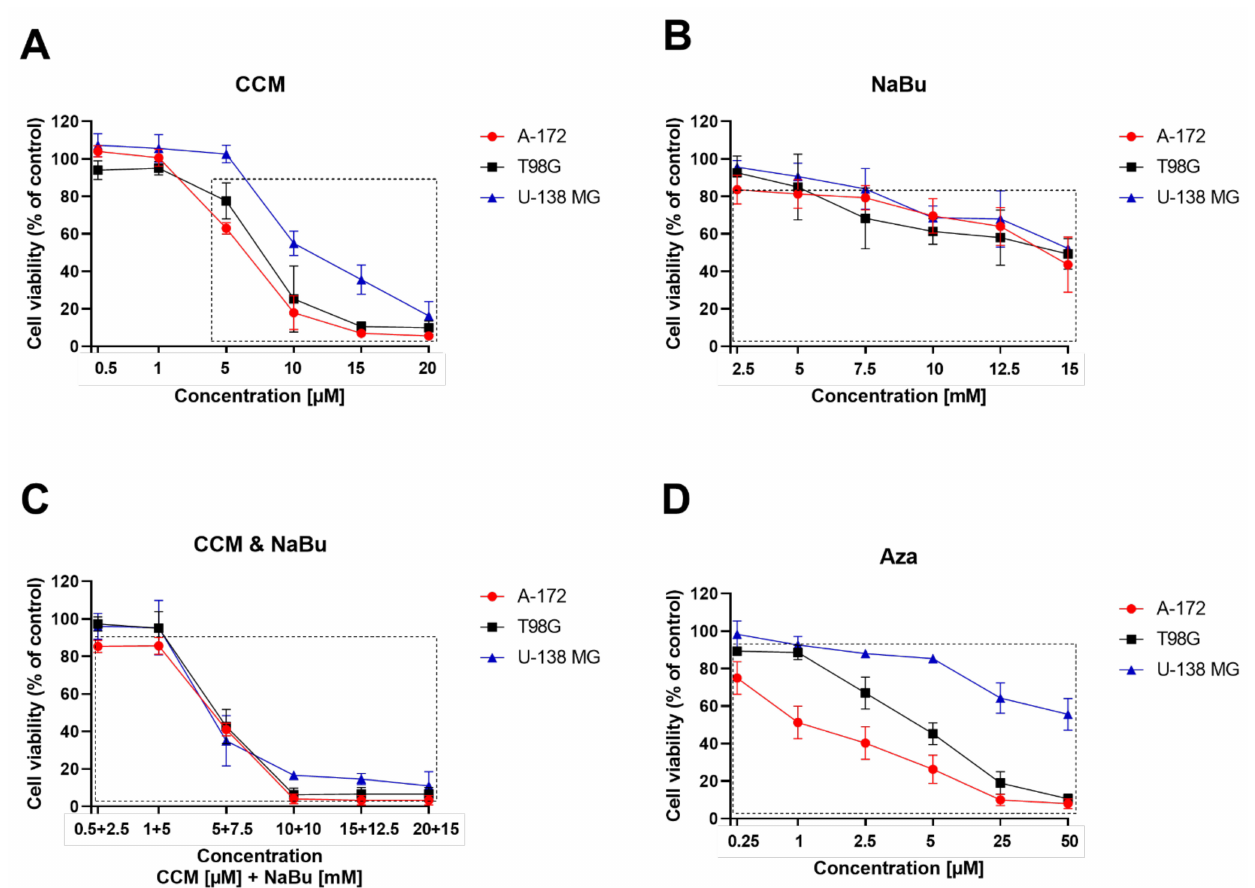
Figure 2. Cytotoxicity evaluation of CCM (Panel A ), NaBu (Panel B ), and their combination treatment (Panel C ), as well as Aza (Panel D ) based on 48 h MTT test on GBM cell lines, A-172 (red), T98G (black), and U-138 MG (blue). Vehicle-treated cells (control) were assigned as 100% cell viability. Statistically significant difference in cell viability between cells exposed to analyzed compound/combination of compounds as compared to that of control cells is indicated with rectangle. Values are shown as mean ± SEM calculated from three independent